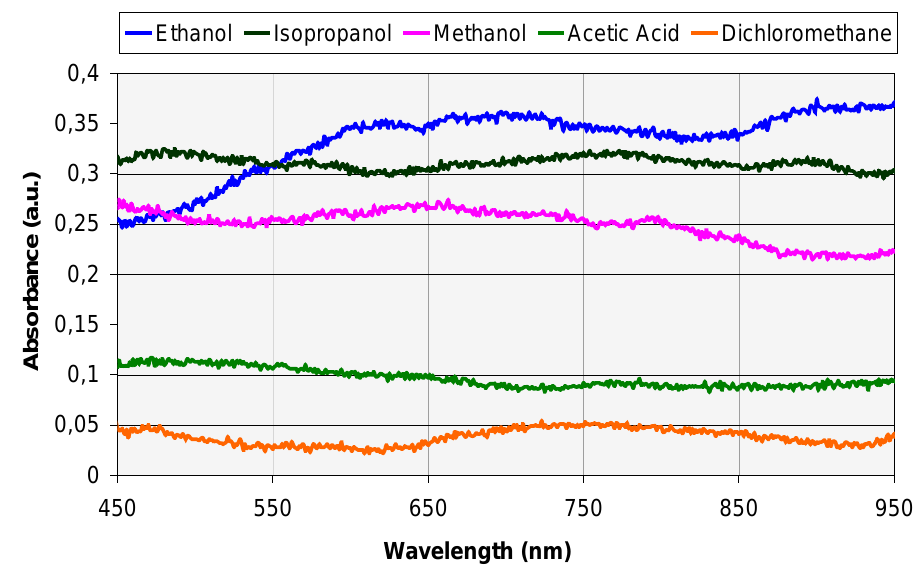
Figure 6. Absorbance spectra of the nanocavity when exposed to different VOCs. The measures were taken after 5 minutes of